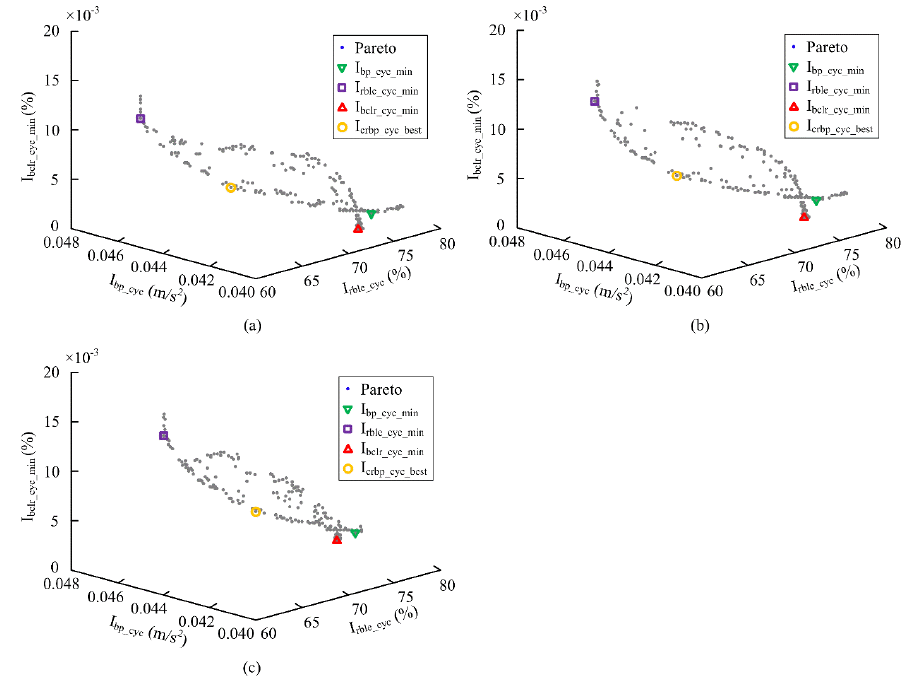
Figure 10. Distribution of the Pareto optimal solution in objective space: ( a ) μ max _ h = 0.9; ( b ) μ max _ m = 0.6; and ( c ) μ max _ l = 0.3.